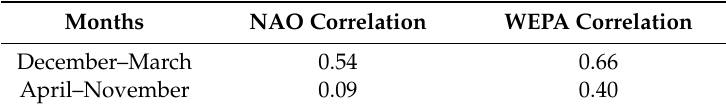
Table 1. Correlation (Pearson) between monthly average P and the monthly NAO and WEPA climate indices, for both the winter and the ‘summer’